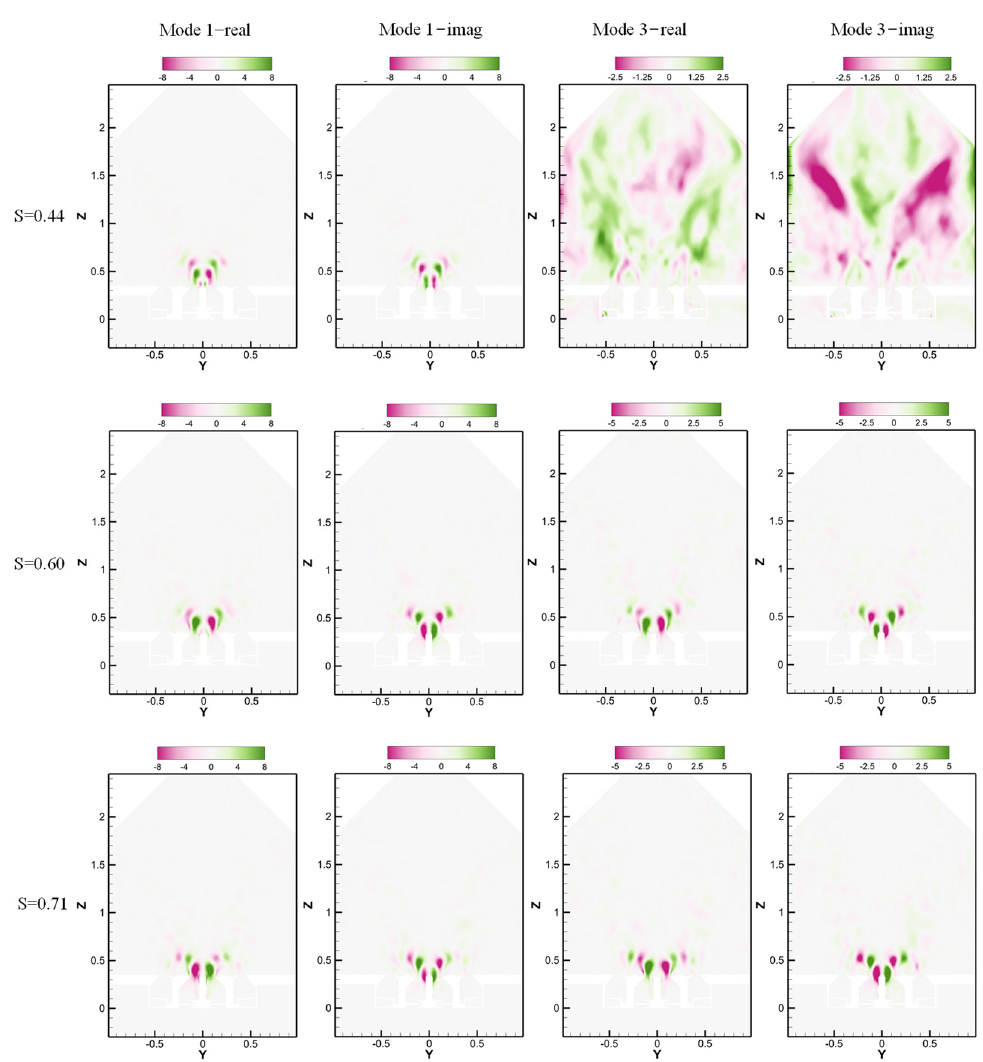
Figure 14. The spatial distribution of the first four modes by DMD.